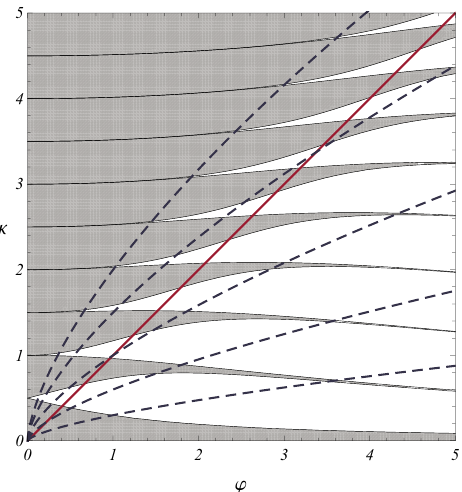
Figure 2 . Stability chart of eq. (2.22) in terms of κ ≡ k/m and ϕ ≡ α a φ os /f a . Shaded area shows the stable regions while white regions correspond to unstable solutions. The thick red line represents κ = ϕ . Below this line ω 2 becomes negative in each period. Dashed blue curves show adiabatic evolution due to the background expansion. As time goes on, any point approaches the origin through these